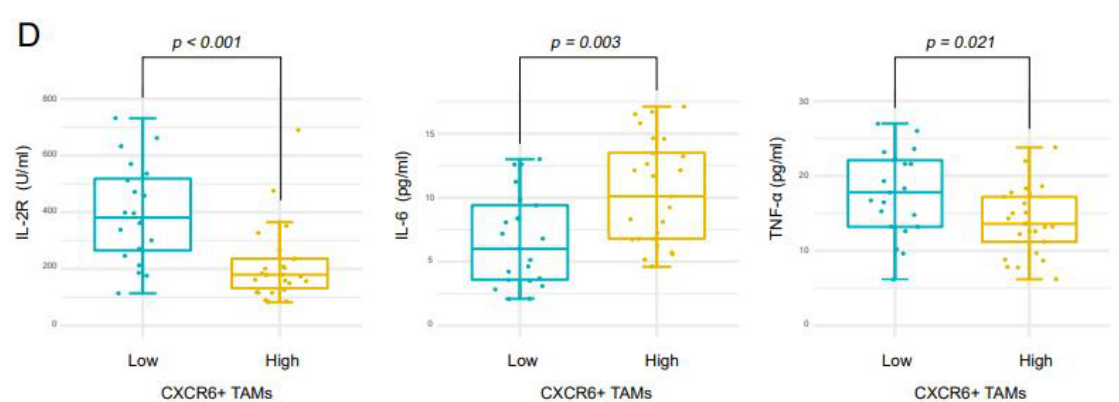
Figure 4. CXCR6+TAMs contribute to an immunosuppressive microenvironment. ( A ) Representative images of CD8+ T cells and GZMB+ cells in CC specimens. ( B ) Correlation between CXCR6+TAMs and CD8+ T cells. ( C ) Correlation between CXCR6+TAMs and activated CD8+ T cells. ( D ) Statistical analysis of the levels of cytokines in CC patients with high and low